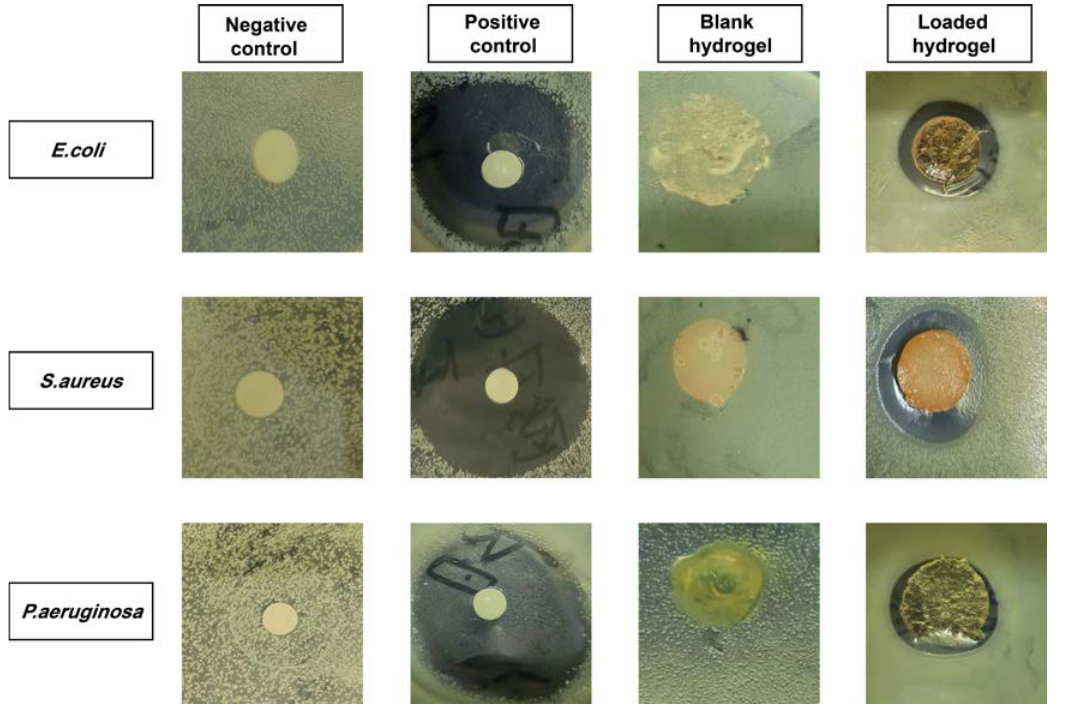
Figure 12. Different inhibition zones were observed against E. coli , S. aureus , and P. aeruginosa using the hydrogels.